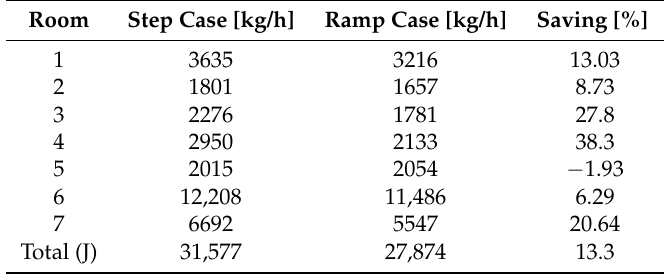
Figure 7. Results obtained by simulating the ARMAX model of room 3 with fan-coil units for one day, 5 December. Table 4. Radiators performance index value (4) for both step and ramp set-point signals determined by the genetic algorithm (5